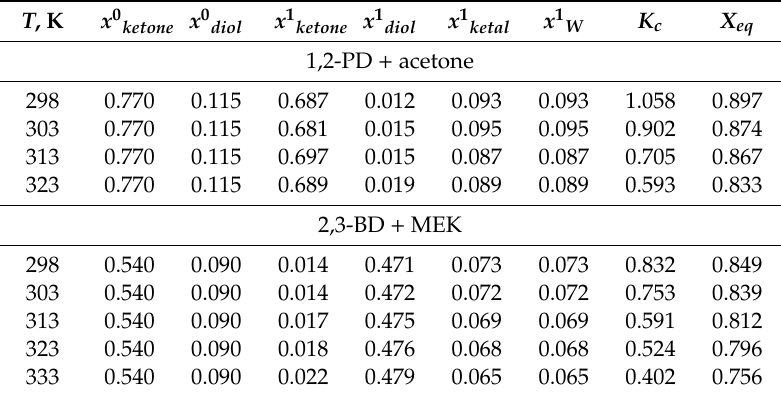
Table 1. The equilibrium compositions of the reaction mixtures obtained by the ketalization of 1,2-PD with acetone and 2,3-BD with MEK. The conditions: the ambient air pressure, keton:diol = 6:1 mol, 5 wt. % (to diol) of Amberlyst 36 dry as the catalyst. T , K